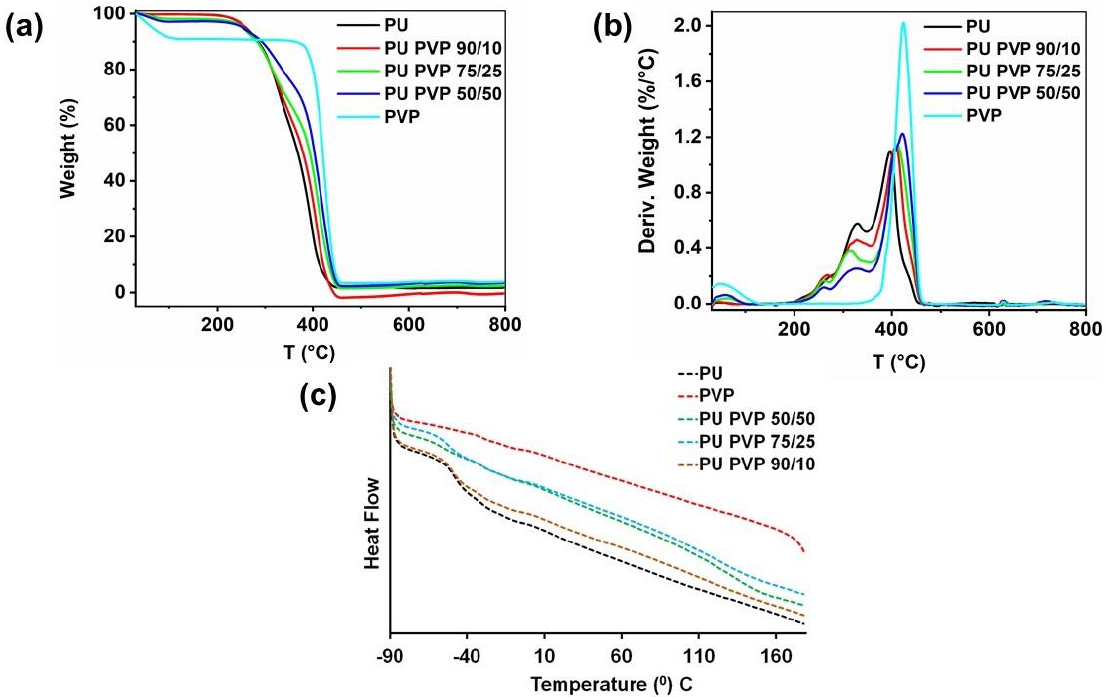
Figure 4. (a ) TGA, ( b ) DTGA, and ( c ) DSC plots of pure and the hybrid films shown in Table